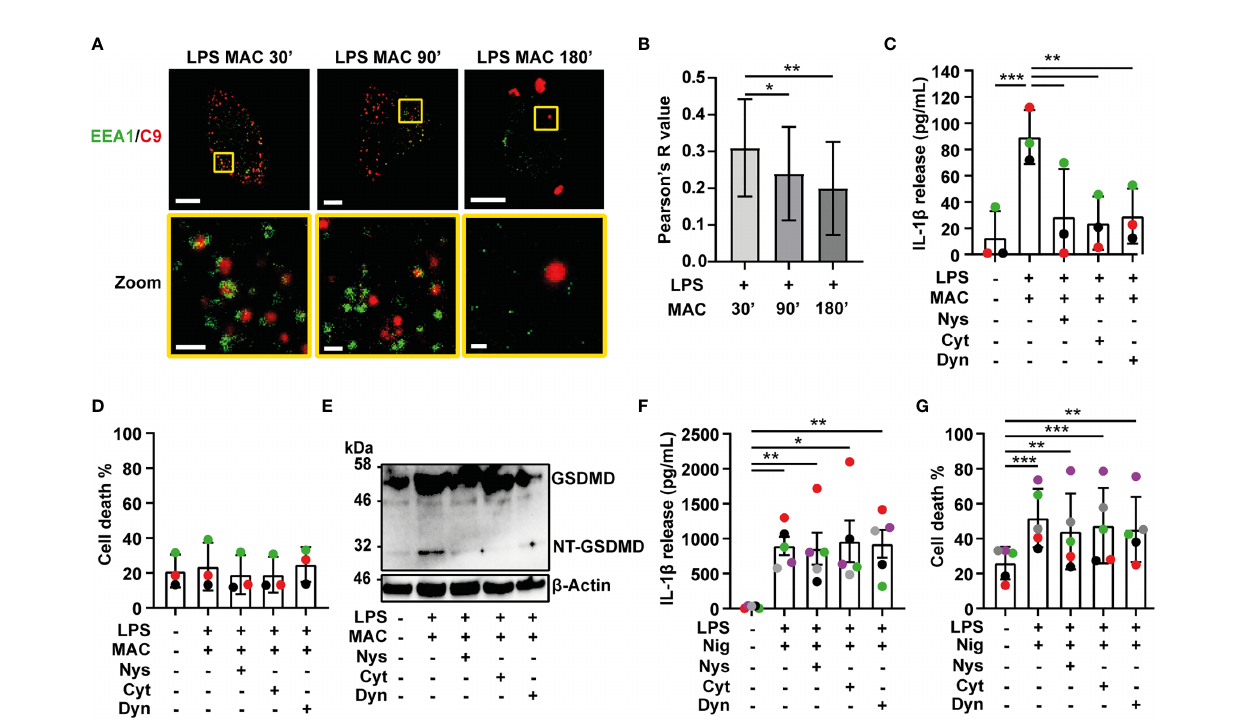
FIGURE 4 | Internalization of the MAC is required for in fl ammasome activation. (A, B) LPS-primed human MDMs were treated with 10 µg/mL anti-CD59 mAb, C5b6, C7, C8 and C9 labelled with AF-647 (MAC) for the indicated time. (A) Confocal imaging of EEA1(green) and C9 (red). Yellow squares represent zoom regions and scale bars are 10 µm in full cell pictures and 1 µm in zoom regions. (B) Pearson ’ s correlation coef fi cient of C9 compared to EEA1. (C – G) Human MDMs were treated with vehicles or primed with 1 µg/mL LPS for 3 hrs followed by stimulation with 10 µg/mL anti-CD59 mAb, C5b6, C7, C8 and C9 for 3 hrs (C – E) or 10 µM nigericin (Nig) for 45 mins (F, G) in the presence or absence of 0.1 µg/mL nystatin (Nys), 10 µM cytochalasin D (Cyt) or 10 µM dyanasore (Dyn). (C, F) IL-1 b secretion was measured by ELISA. (D, G) LDH release was measured as a proxy for cell death. (E) GSDMD processing was analyzed in cell lysates by immunoblot. (C, D, F, H) Data is plotted as mean±SD, each color represents a matched donor and statistical signi fi cance was measured by one-way ANOVA (B – D, G) or Friedman ’ s test (F) (*p < 0.05, **p < 0.01, ***p < 0.001). (A – G) Data is representative of 3 (A – E) or 5 (F, G) independent